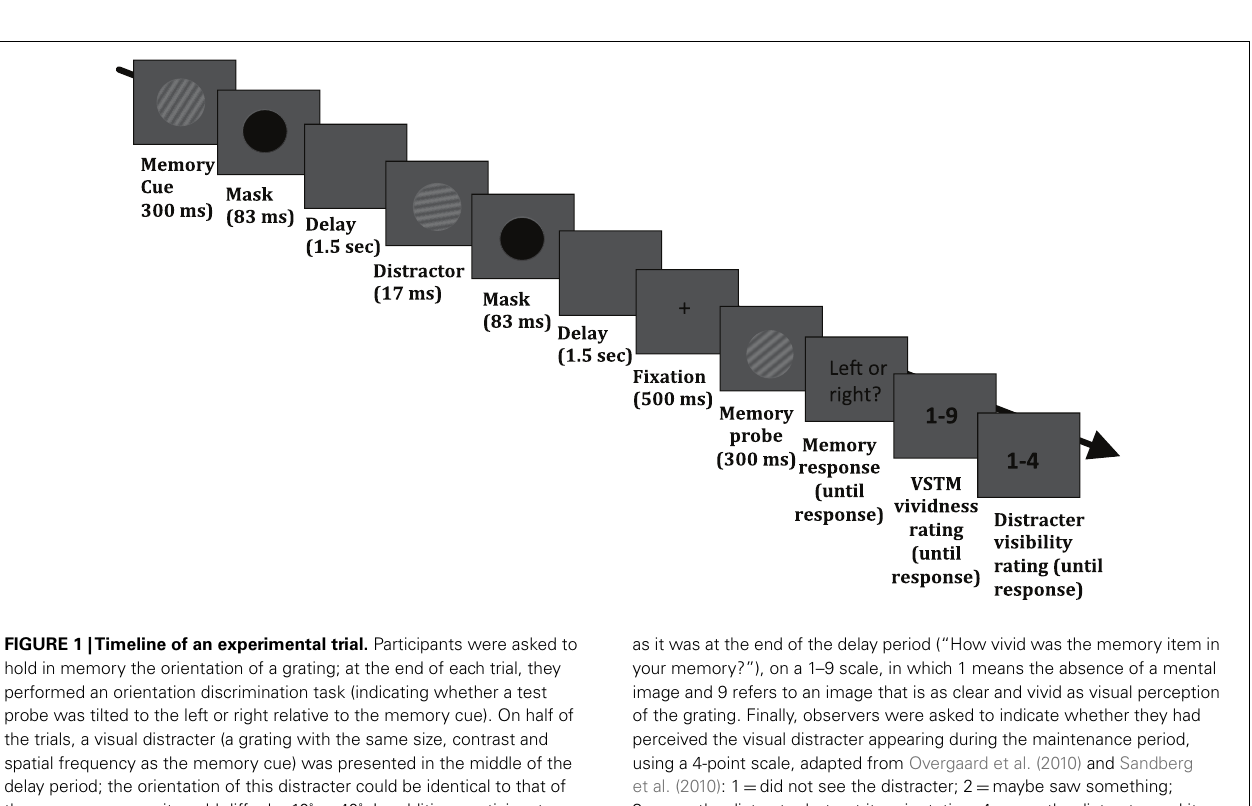
as it was at the end of the delay period (“How vivid was the memory item in your memory?”), on a 1–9 scale, in which 1 means the absence of a mental image and 9 refers to an image that is as clear and vivid as visual perception of the grating. Finally, observers were asked to indicate whether they had perceived the visual distracter appearing during the maintenance period, using a 4-point scale, adapted from Overgaard et al. (2010) and Sandberg et al. (2010): 1 = did not see the distracter; 2 = maybe saw something; 3 = saw the distracter but not its orientation; 4 = saw the distracter and its